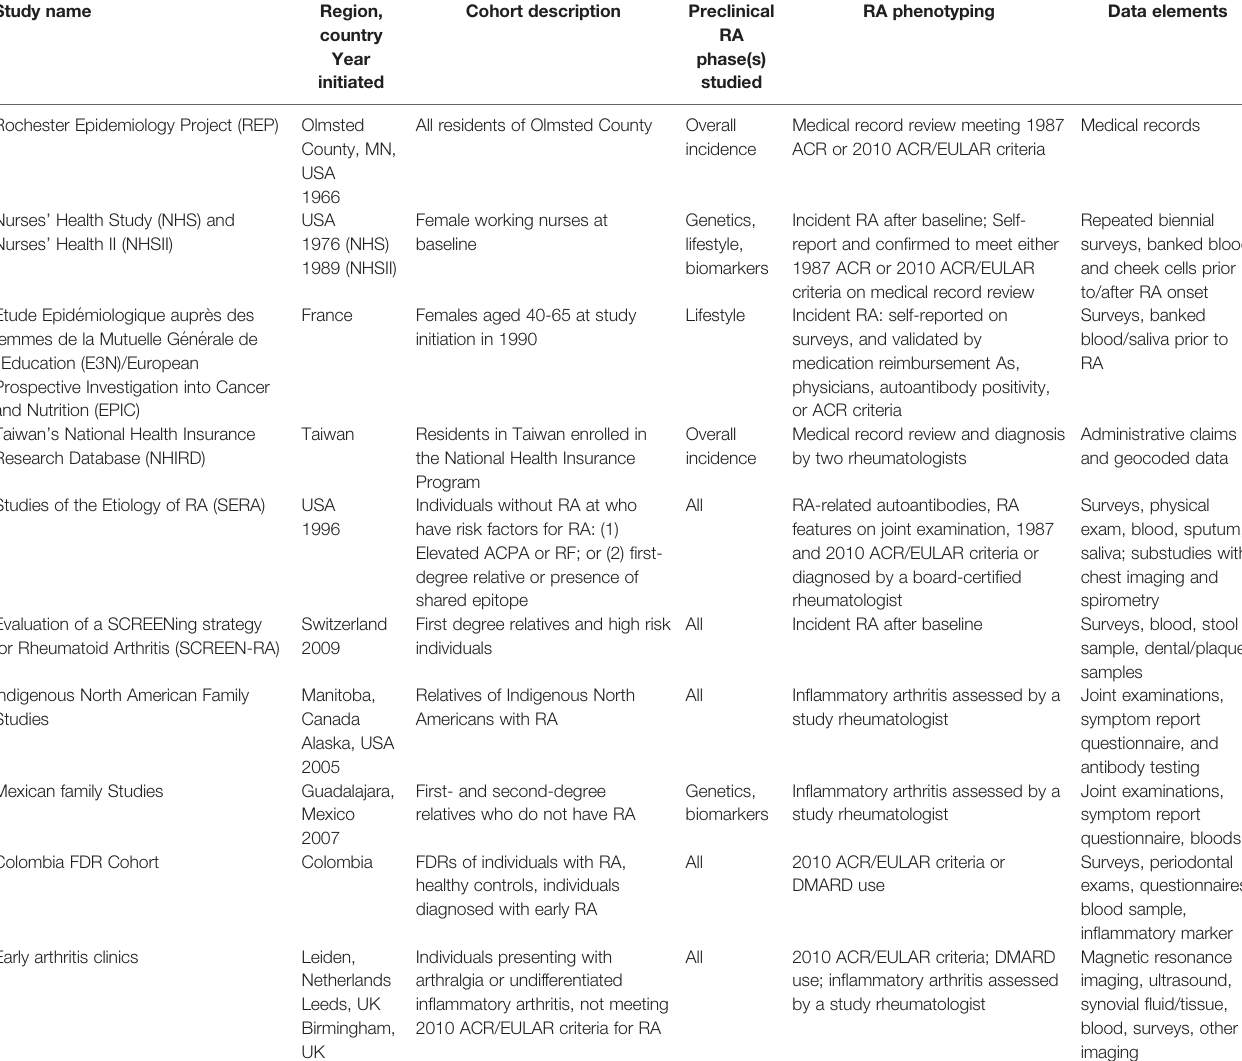
TABLE 1 | Selected observational studies investigating rheumatoid arthritis